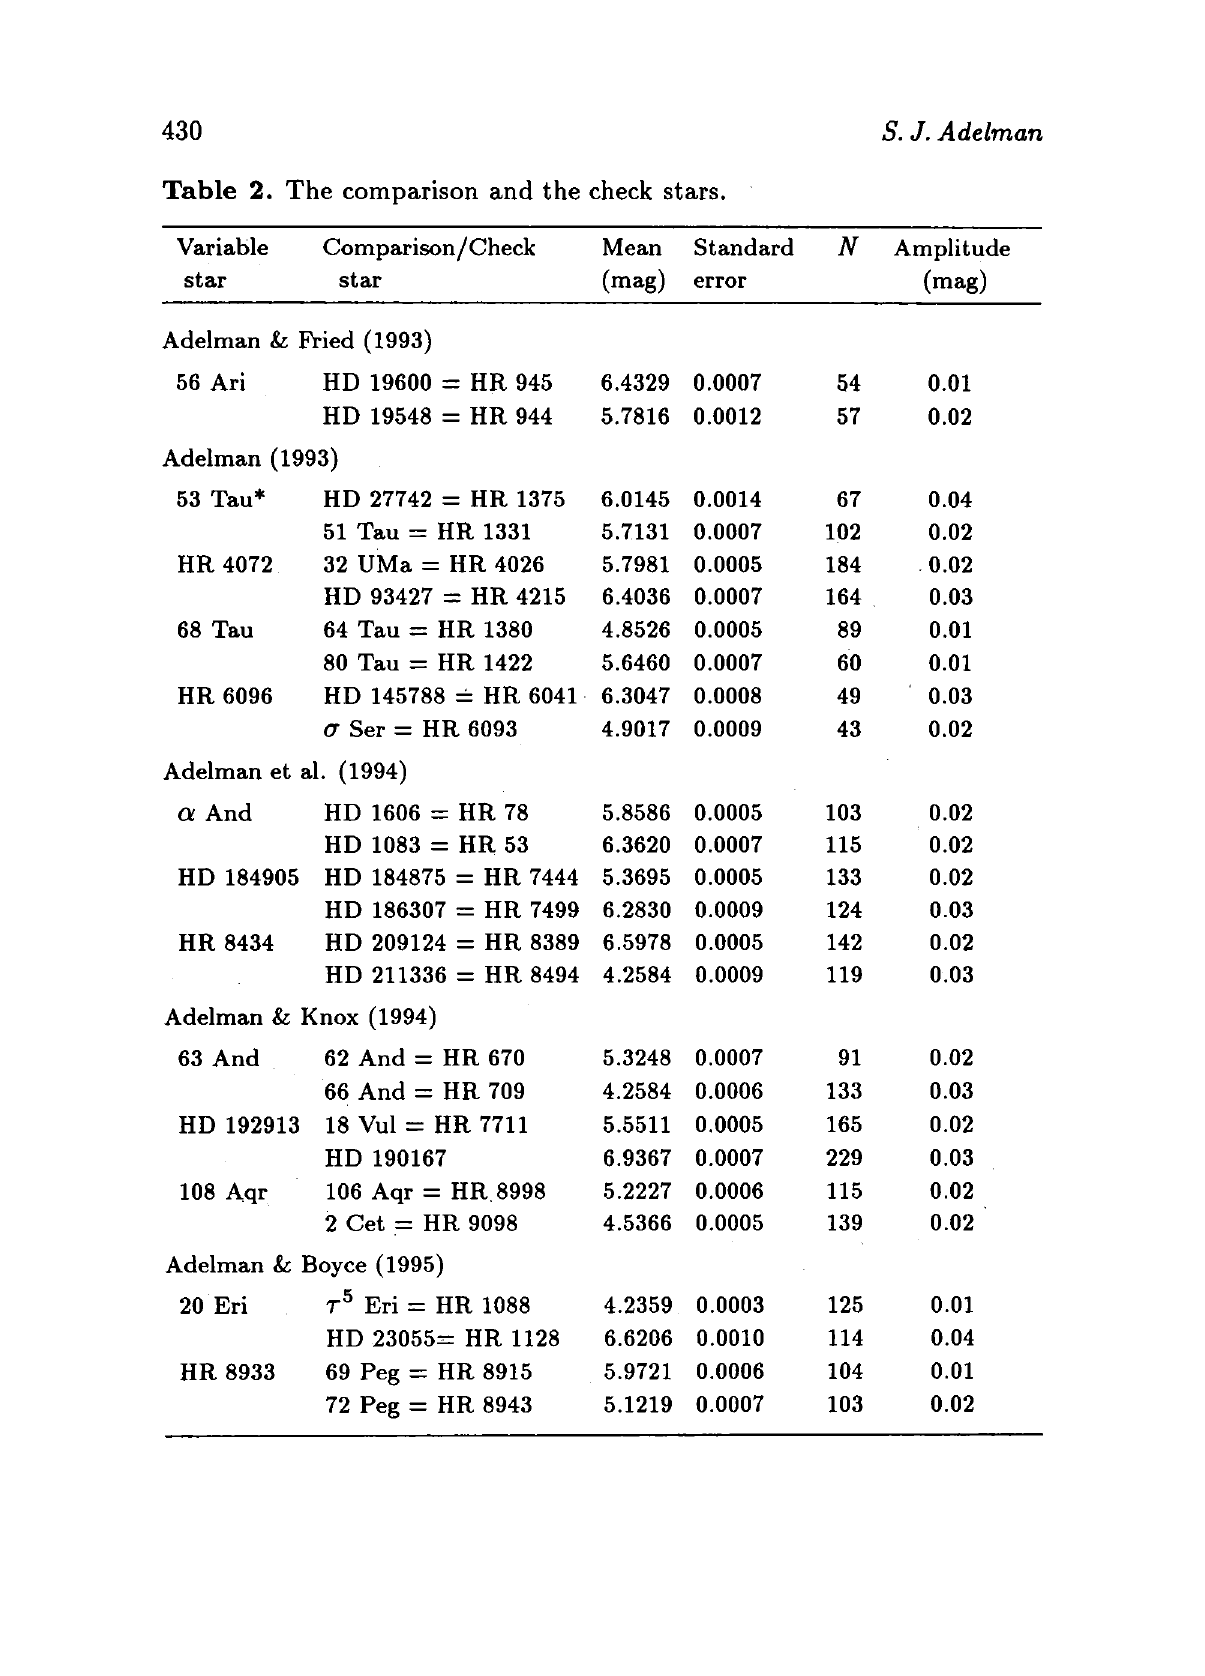
Table 2. The comparison and the check stars. Variable Comparison/Check Mean Standard N Amplitude star star ( ma g) error ( ma